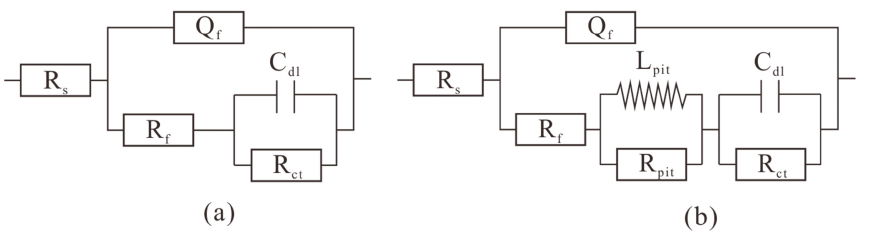
1120 Table 3. Fitted electrochemical parameters for AZ31B magnesium alloy after immersion in abiotic mudflat. Time (day)